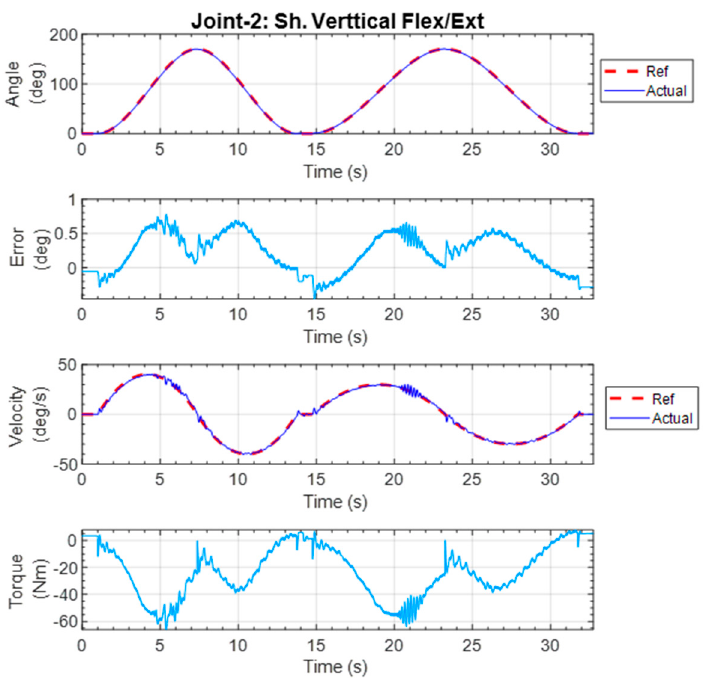
Figure 20. Individual joint exercise for shoulder vertical flexion–extension.